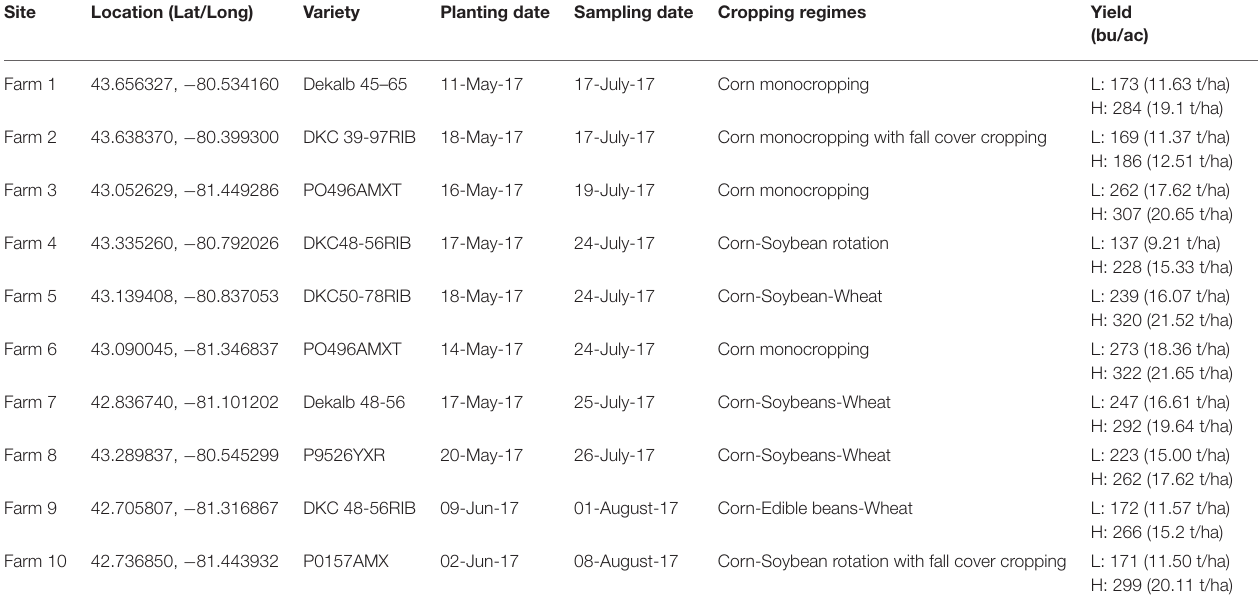
TABLE 1 | Field sites, corn variety, sampling information and the cropping regimes. Site Location (Lat/Long) Variety Planting date Sampling date Cropping regimes Yield